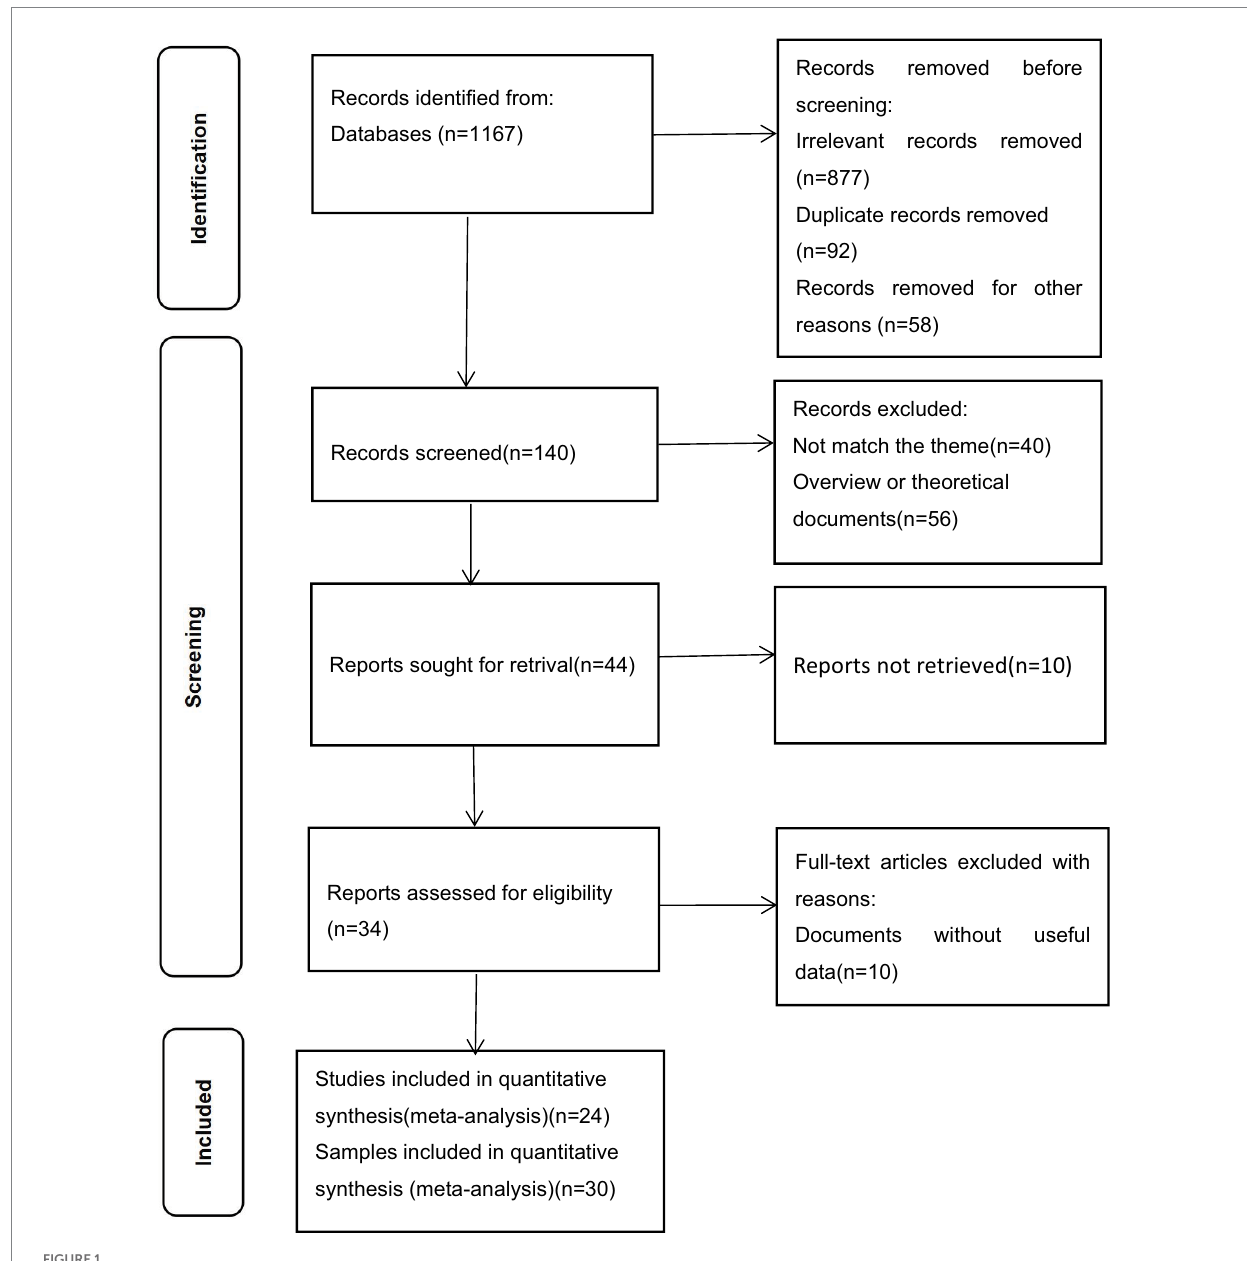
FIGURE 1 The PRISMA flow chart used to identify studies for detailed analysis of IGD and